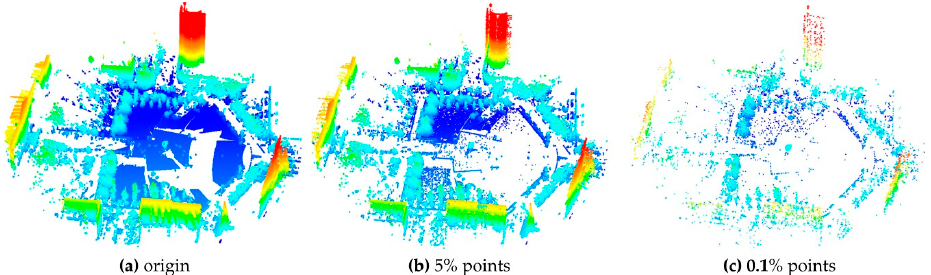
Figure 3. Normal space sampling. The point clouds are rendered by elevation. ( a ) The point cloud before normal space sampling; ( b ) the point cloud after 5% points were selected; ( c ) the point cloud after 0.1% points were selected.